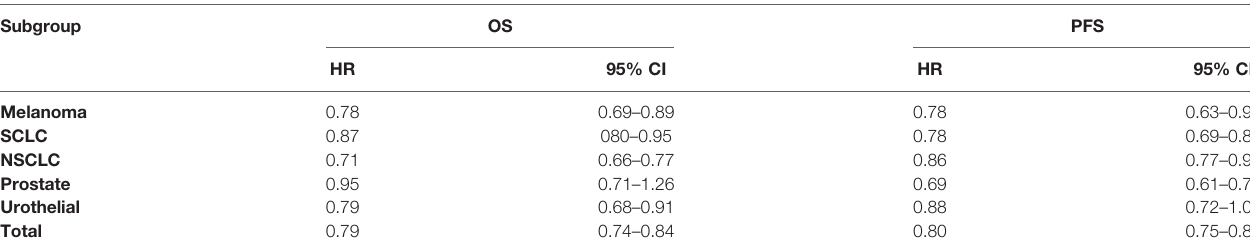
TABLE 3 | The summary of the meta-analysis with OS and PFS.